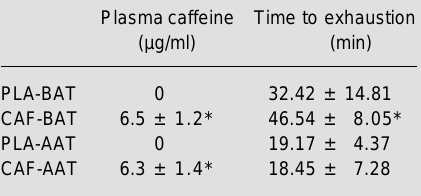
Table 1 - Effect of caffeine on plasma caffeine concentration and time to exhaustion. Data are reported as means ± SD for plasma caffeine concentration immediately before exer- cise and for time to exhaustion for the experimen- tal conditions caffeine (CAF; 5 mg/kg) and placebo (PLA) during exercise below (BAT) and above (AAT) the anaerobic threshold. *P<0.05 compared to PLA at the same intensity of exercise for N = 8 (Student t-test).